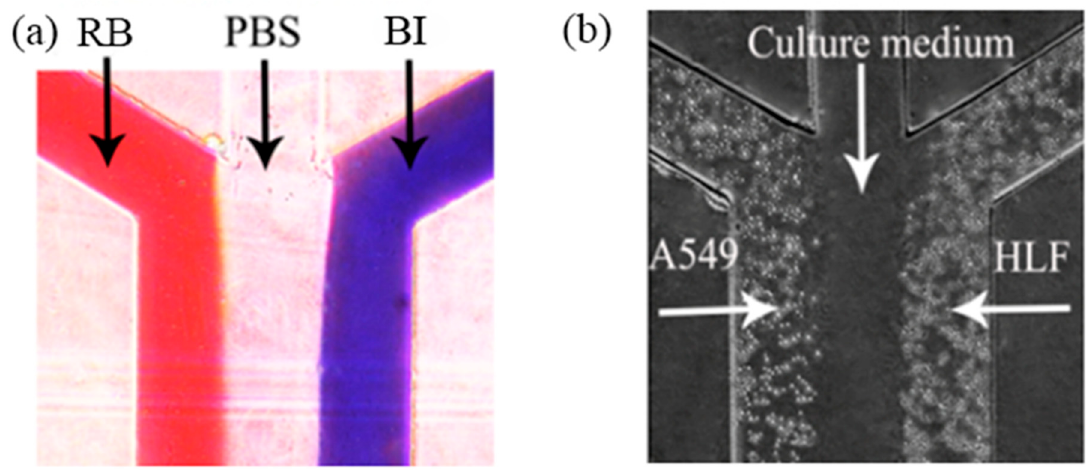
Figure 3. ( a ) Parallel flow testing. Red flow is rhodamine B; blue flow is blue ink; bright flow is PBS. ( b ) Different cells adhered on opposite sides of the main microchannel.